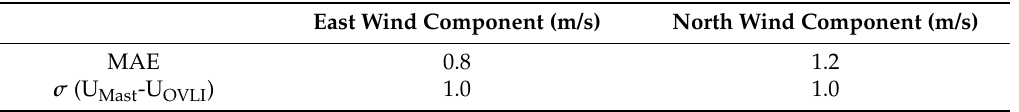
Table 3. Mean absolute error of east and north wind speed. Standard deviation of the difference between east (or north) wind component measured respectively by the 60 m mast and OVLI-TA.